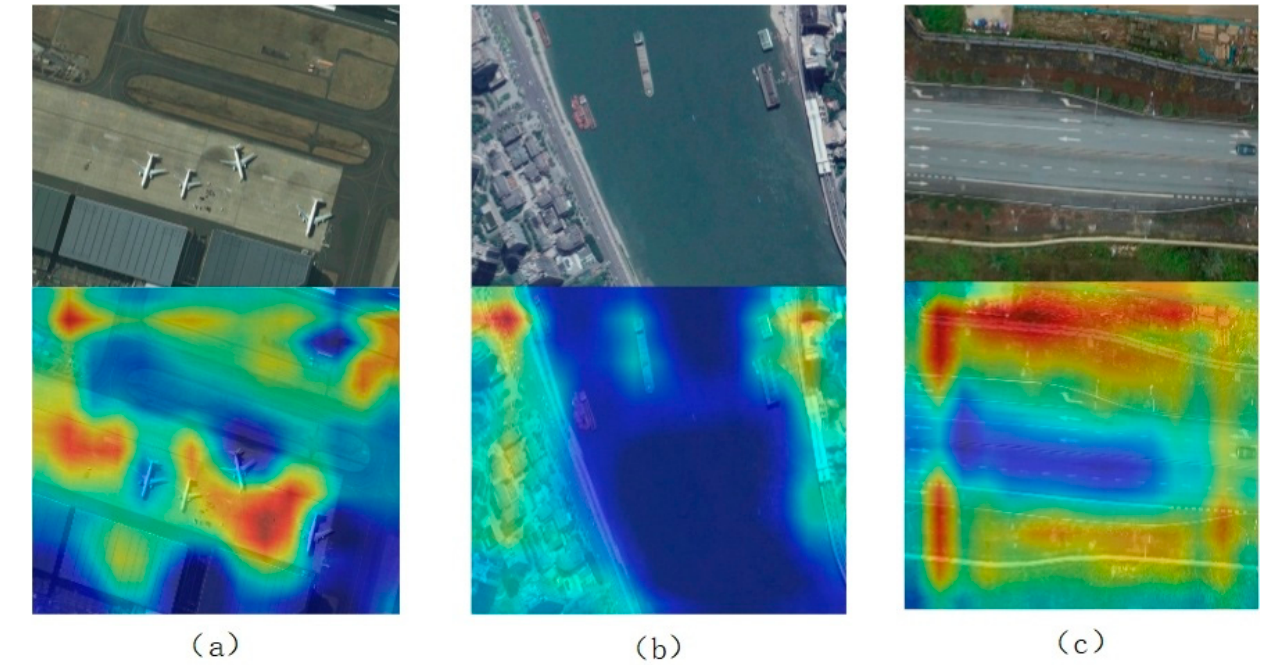
Figure 12. The heat maps of the collected dataset. ( a ) Airplane; ( b ) Ship; ( c ) Car. Table 4 shows the AC value and PR value of the collected dataset. It can be seen from Table 4 that the proposed DCIFF-CNN obtains better detection results than other methods. For the target of airplane, the DCIFF-CNN achieves 2.85% better AC and 5.25% better PR than the YOLO4. Furthermore, the proposed method obtains a value of 90% in both AC and PR, demonstrating that the proposed DCIFF-CNN can maintain a low false alarm rate with a high recall rate. For the target of ship, there are two different backgrounds, and the number of targets is more than that of other targets. In this situation, the proposed DCIFF-CNN is superior to other methods, showing that the proposed ORSG and AMIM are robust to various complex backgrounds. For the target of car, the AC value obtained by YOLO4 is slightly higher than that of the proposed method. However, the proposed method achieves the highest PR value. This demonstrates that the proposed DCIFF-CNN is stable for detecting small and dense targets, due to the efficient use of context information by the added ORSG and AMIM. Table 4. Performance comparisons of various methods on the collected